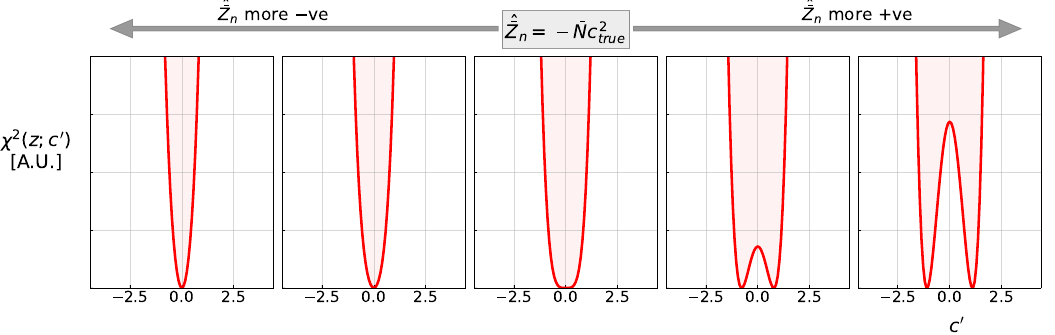
Figure 2: Illustration showing how the χ 2 -profile for a purely quadratic EFT model ˆ¯ Z ˆ¯ Z > − ¯ Nc 2 , the profile has two equal χ 2 -minima. Below . When depends on n n true this threshold it has only one, always at c ′ = 0. This causes the conditional statement in Eq